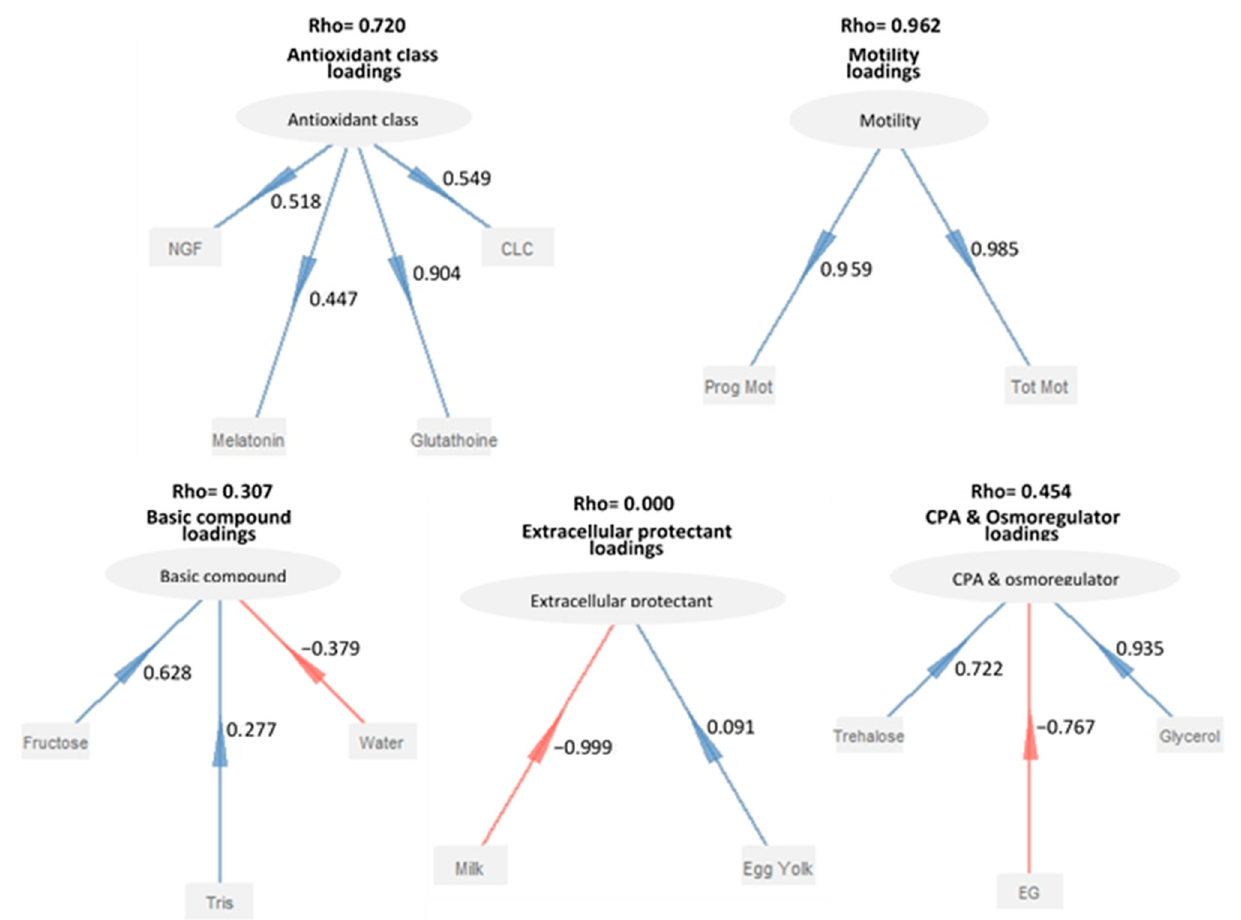
Figure 7. Loadings between basic compounds, extracellular protectants, CPA and osmoregulators, antioxidant classes, and motility and their relative parameters in PLS models. The values above each block are the Dillon-Goldstein rho (DG rho).